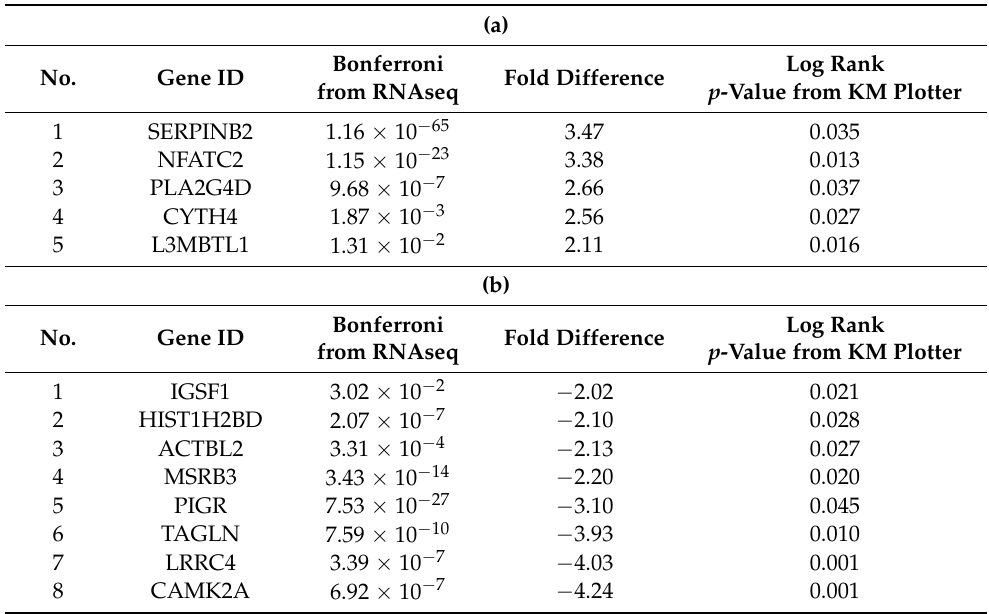
Table 2. Genes whose up- ( a ) or down- ( b ) regulation upon treatment with 5 µ M CHDI0039 for 24 h in Cal27_HDAC4 promote increased survival in head–neck cancer patients according to analysis by KM plotter database